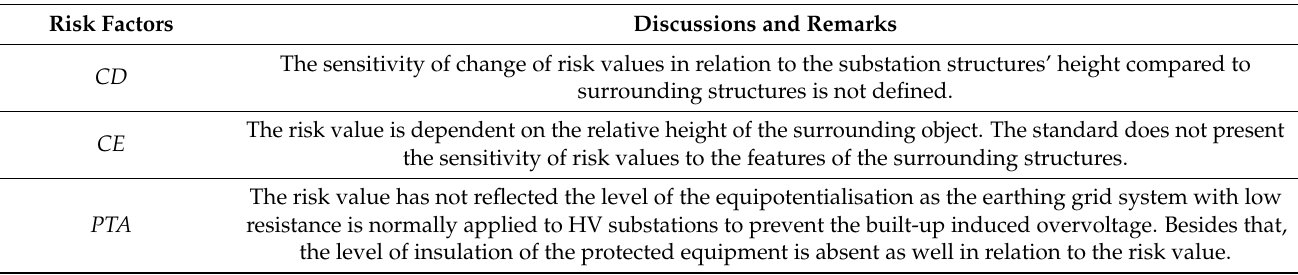
Table 14. Ambiguous Risk